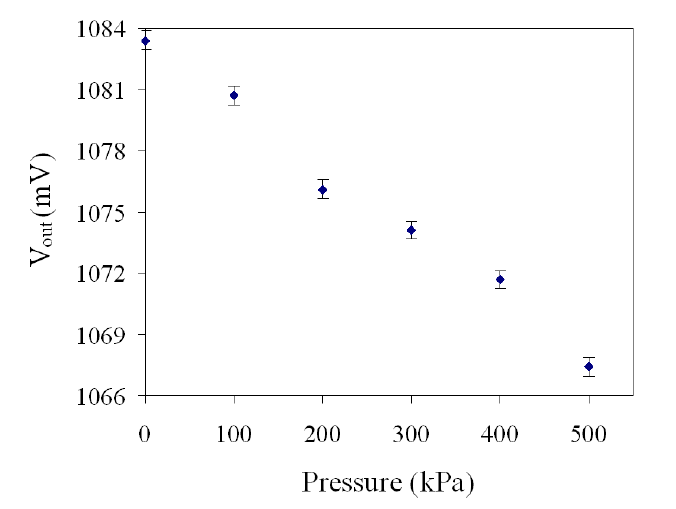
Figure 16. Output voltage of the FET pressure sensor with